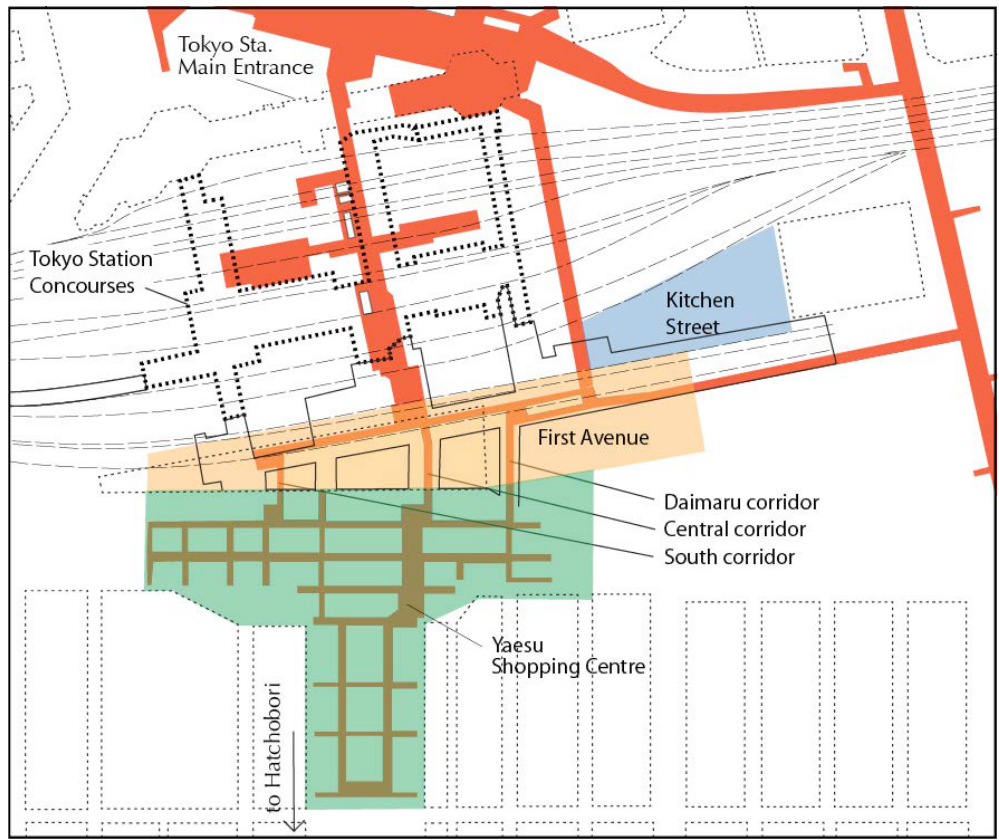
Figure 3. The indoor walking network of Tokyo Station City includes several urban development projects, including First Avenue and Yaesu shopping